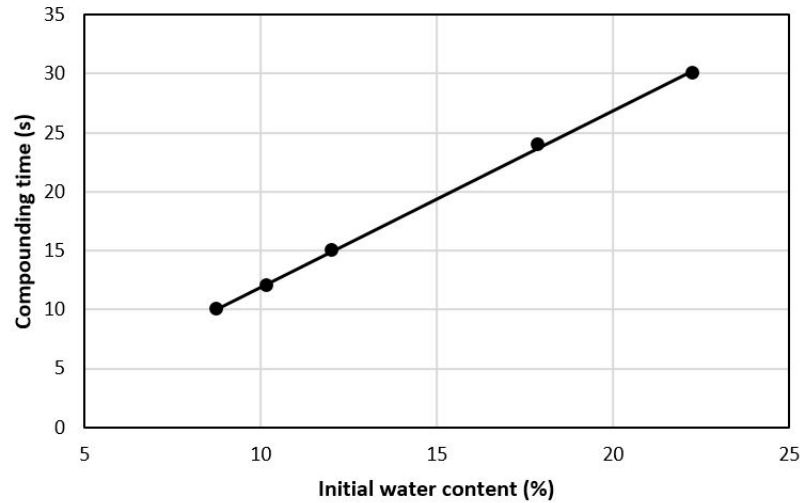
Figure 6. Effect of water content on batch time for the thermokinetic mixing of PP-CNC compo- sites [80].